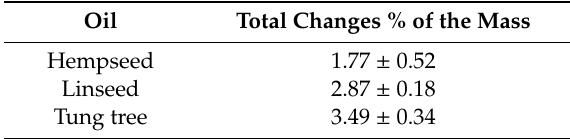
Table 2. The total mass changes due to the autooxidation of di ff erent oil types.